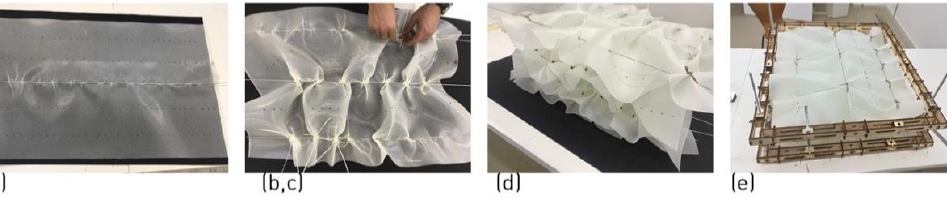
Figure 2. L-FMFRP fabrication process: ( a ) introducing metal rods in pre-cut holes in the fabric; ( b ) contracting the fabric at points along the rod; ( c ) assuring the local contractions with a temporary string; ( d ) super-imposing the manipulated fabric; ( e ) contracting the layered assembly with a jig for oven curing.